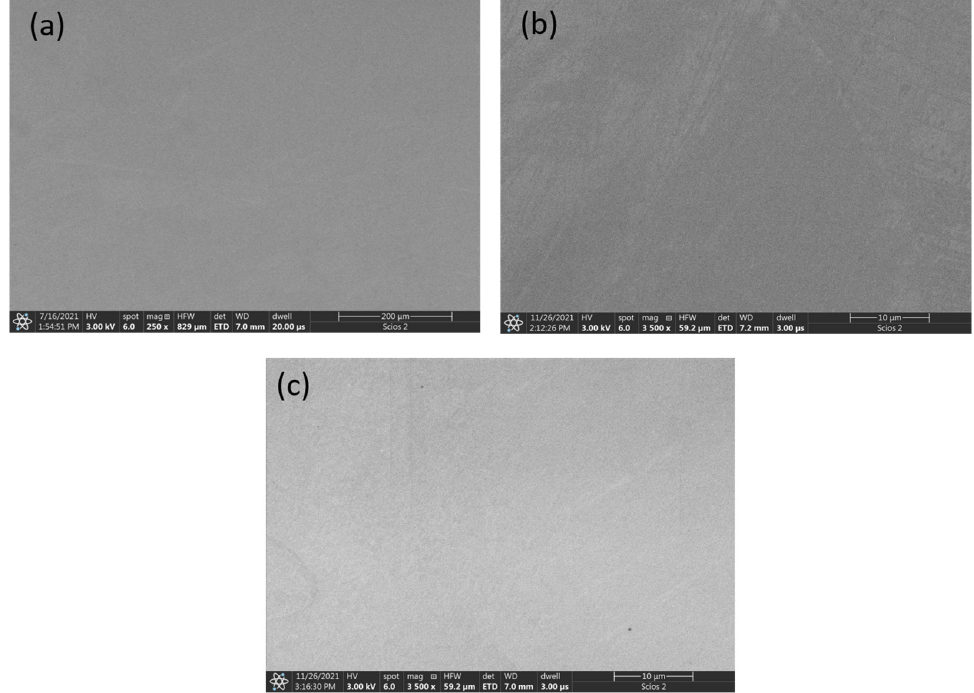
Figure 5. SEM micrographs of CoCrFeNi alloy: ( a ) as ‐ cast, ( b ) annealed at 500 °C, and ( c ) annealed at 900 °C.